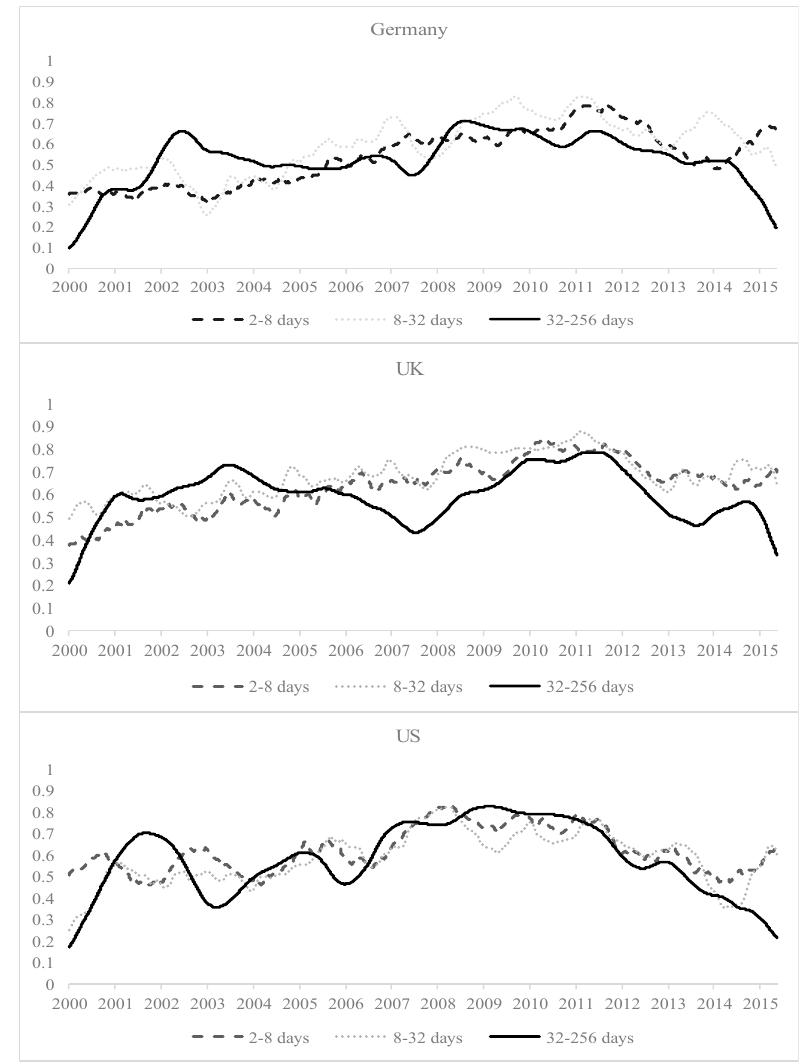
Figure 4. Rolling estimation of the PTV of wavelet coherence between the securitized real estate and stock markets over the three investment horizons. Notes: This figure displays the rolling estimates of the PTV of wavelet coherence between pubic real estate and the stock markets for the five economies inside the cone of influence with a rolling window of 250 trading days (around one year). Dotted lines represent the rolling estimates corresponding to the frequency band from two to eight trading days (short run). Dashed lines show the rolling estimates from eight to 32 trading days (medium-term) and the solid lines refer to the frequency band from 32–256 days (long-run).